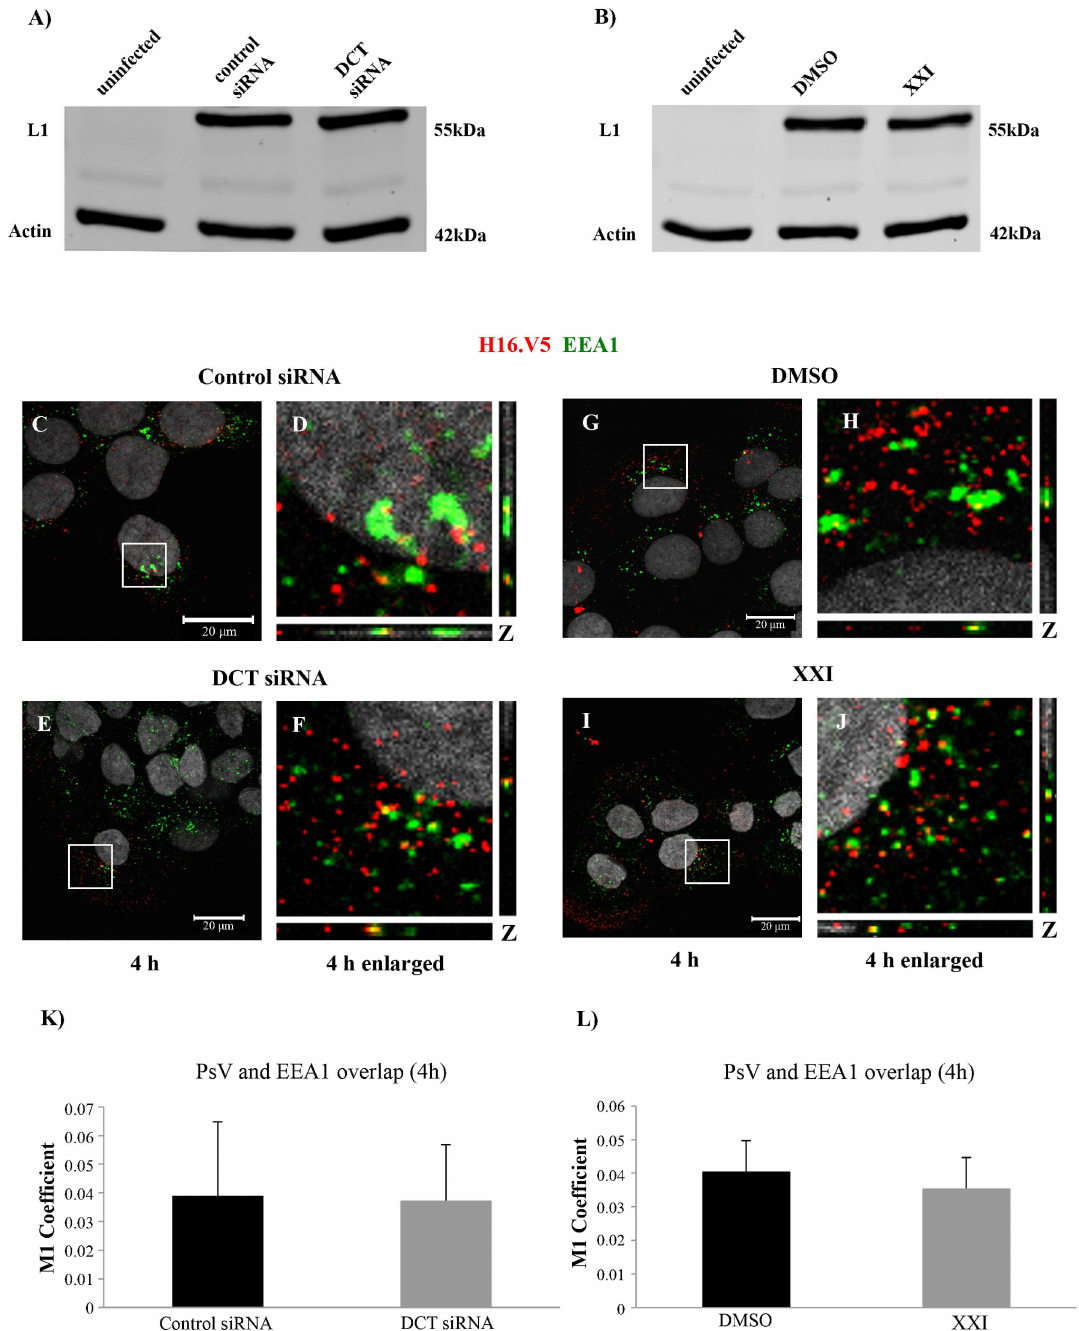
Fig 2. DCT siRNA or XXI treatment does not interfere with binding and early endosome localization of HPV16 PsV in HaCaTs. Western blot analysisof L1 and actin levels in (A) uninfected, control and DCT siRNA transfected HaCaTs, (B) uninfected, DMSO and 300pMXXI treated HaCaTs. (C-J) Immunofluorescence analysesof EEA1 (green), L1 (red) in control and DCT siRNA transfected and DMSO and XXI treated cells. Nuclei are stainedwith DAPI (grey). Colocalization of L1 and EEA1 appearsyellow. (K and L) The JACoP pluginfor ImageJ was used to measurethe M1 coefficient(fraction of red signal overlapping with green signal) with three confocalscans for each condition.